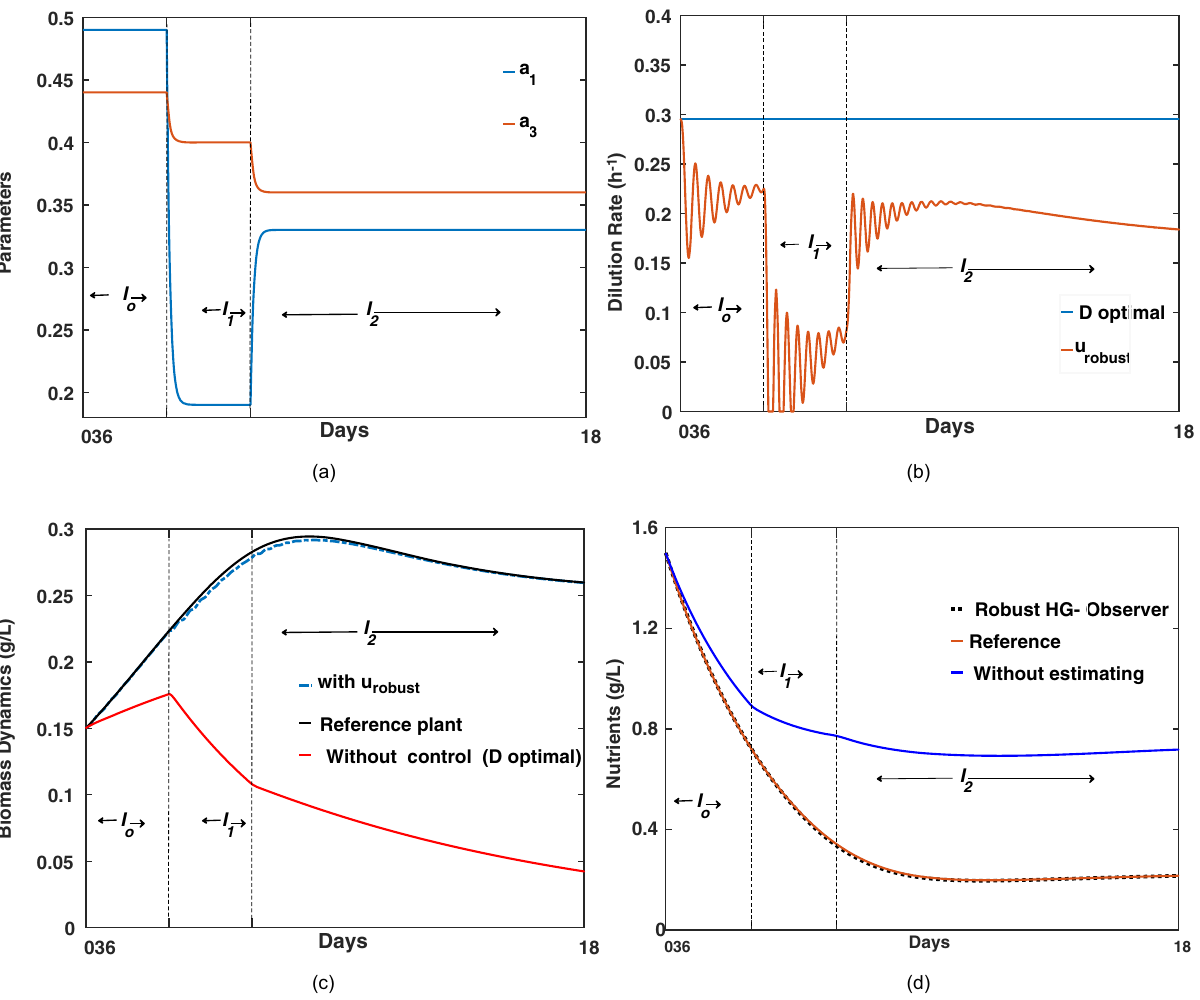
Figure 2: Simulations obtained for ( a ) dynamics of parameters a 1 and a 3 for nominal = I 150 μmol m s photons 0 −2 −1 ( b ) control signal obtained through ( 19 ) to minimize the e ff ect of parameter change a in the absence of the controller and the optimal reference; and ( d ) estimated nutrient dynamics using observer ( 16 )